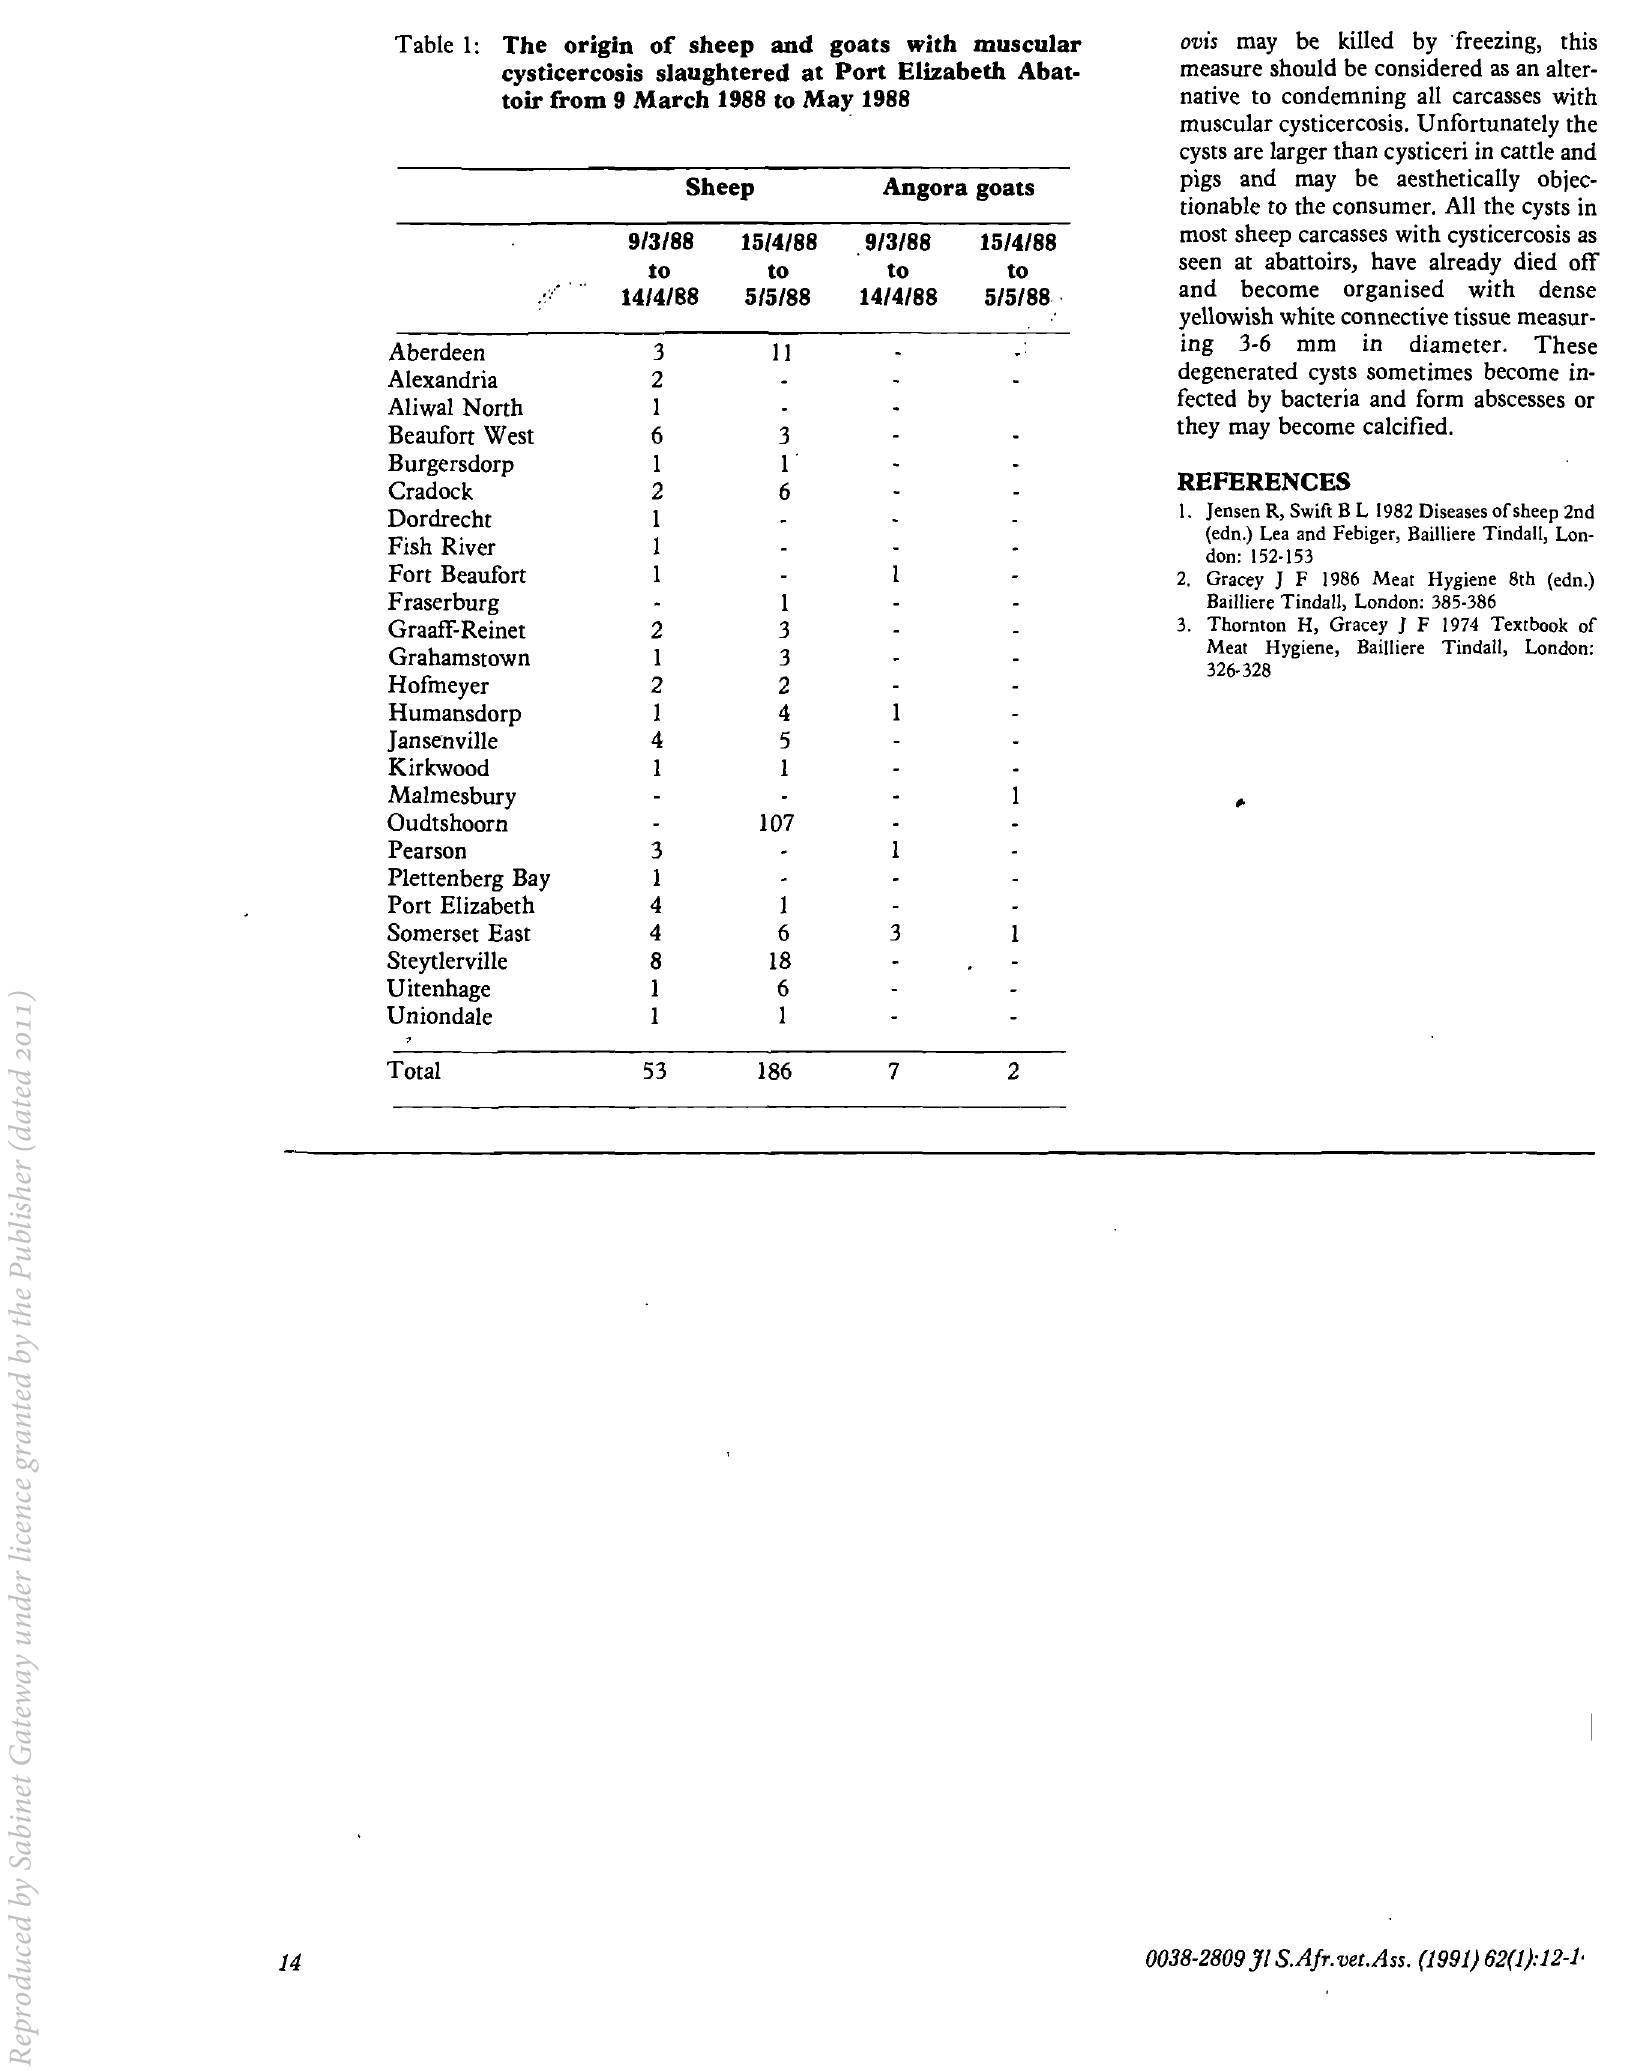
Table I: The origin of sheep and goats with muscular cysticercosis slaughtered at Port Elizabeth Abat toir from 9 March 1988 to May 1988